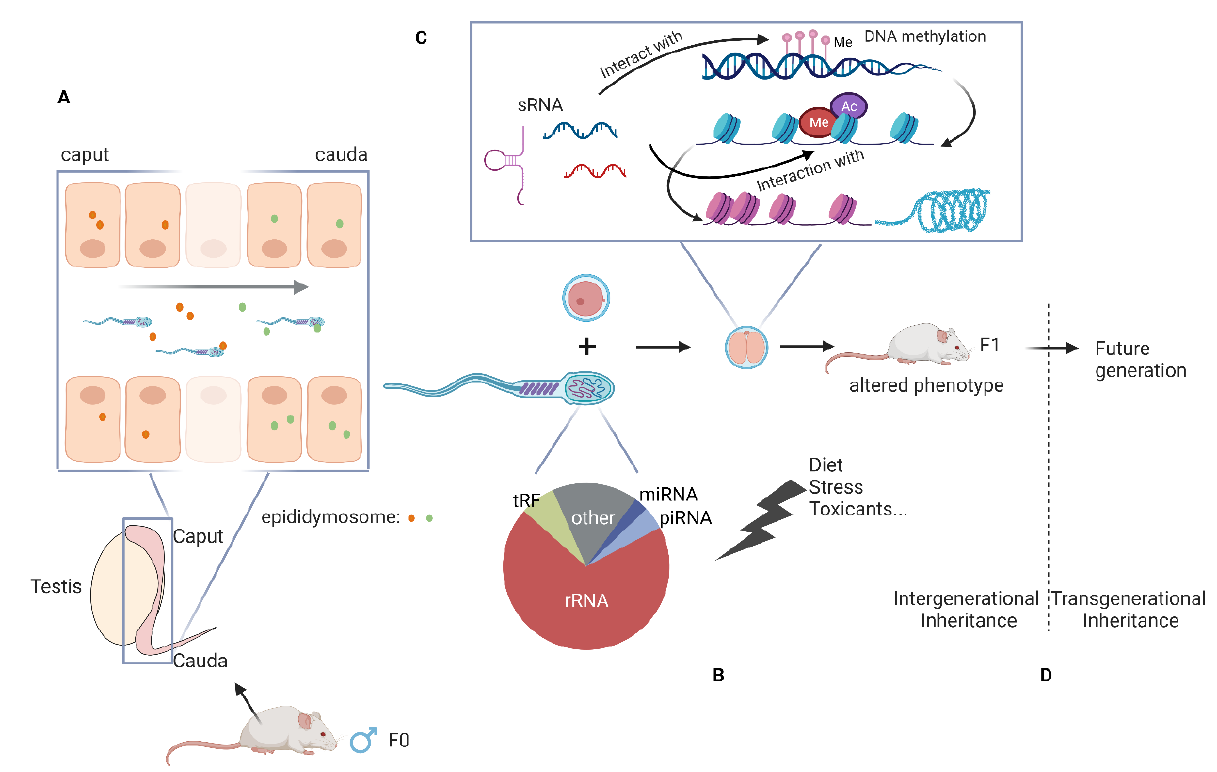
Figure 2. Model for intergenerational inheritance via sperm RNAs: ( A ) Epididymis shapes the small RNA payload of mature sperm. Small RNAs are delivered from the epididymis epithelial cells to sperm via extracellular vesicles known as epididymosomes represented by orange and green dots to depict different types of vesicles. ( B ) Mature sperm in mice are chiefly comprised of rsRNAs, tRFs, miRNAs, and piRNAs. Various studies demonstrate that levels of sperm small RNAs are altered in response to paternal environmental conditions. ( C ) Different epigenetic marks, including DNA methylation, histone modifications, and small RNAs, can function synergistically to regulate intergenerational epigenetic inheritance and influence offspring phenotypes. ( D ) In males, intergenerational inheritance involves the transmission of paternal environmental effects from F0 to F1. In some instances, paternal environmental effects can be transmitted to F2 and later generations, constituting transgenerational